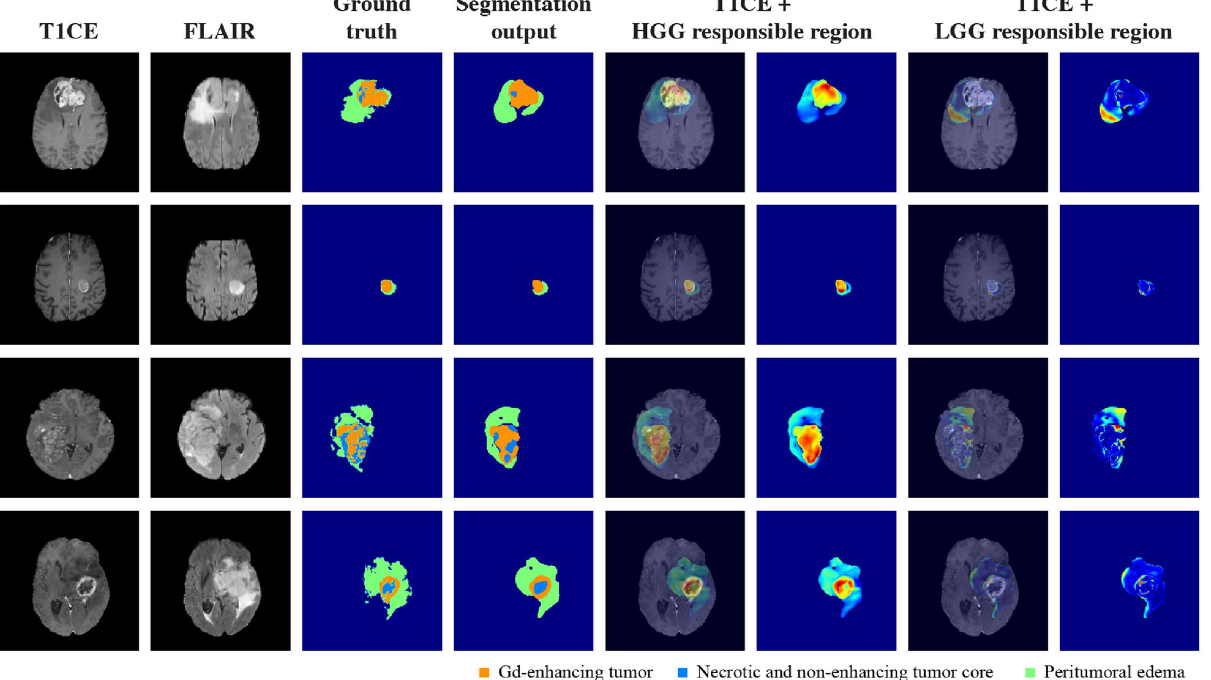
Figure 5. Example results for responsible regions in HGG patients. For patients with HGG, the Gd-enhanced T1 (T1CE) and FLAIR sequences, ground-truth labels, segmentation outputs, HGG responsible regions, and LGG responsible regions are shown. The tumor regions are adequately correlated with the HGG responsible regions, but overlap with the LGG responsible regions is scarce. The color map indicates the high-difference values in red and the lower-difference values in blue; the values are standardized for each